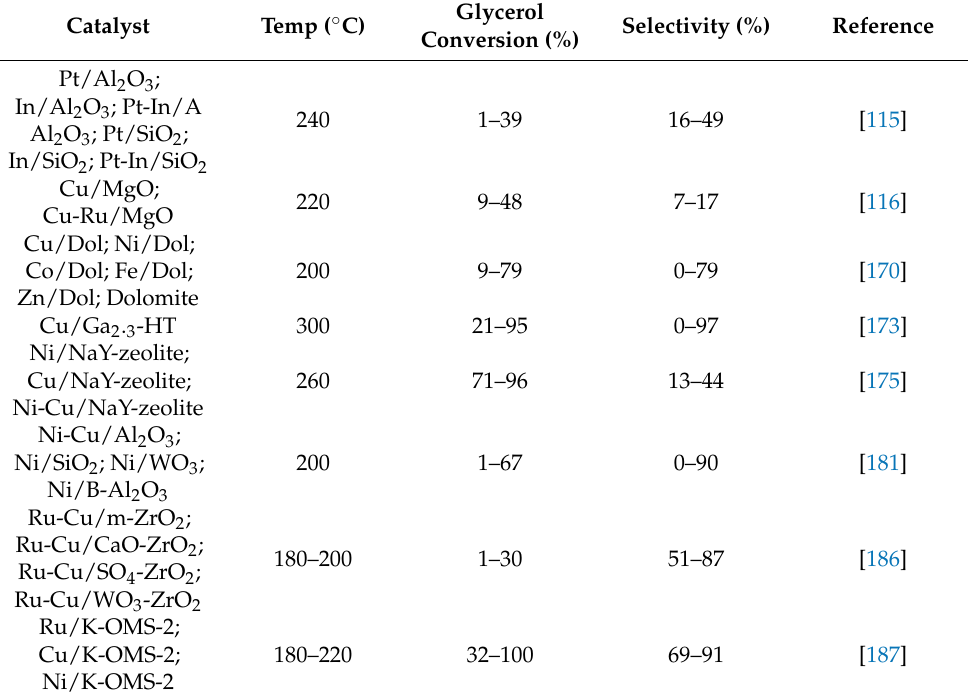
Table 7. A summary of recent studies on glycerol hydrogenolysis to produce